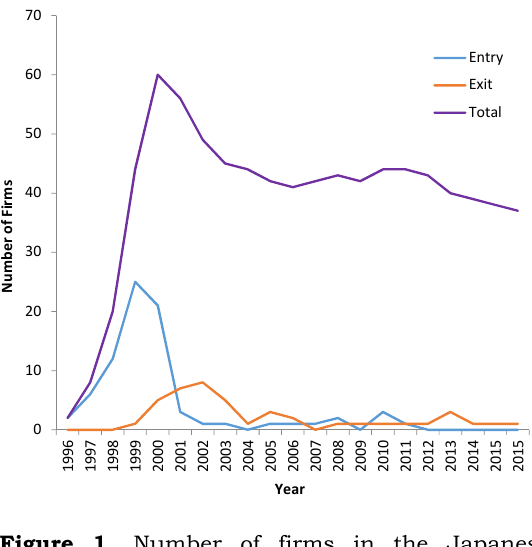
Figure 1. Number of firms in the Japanese online securities